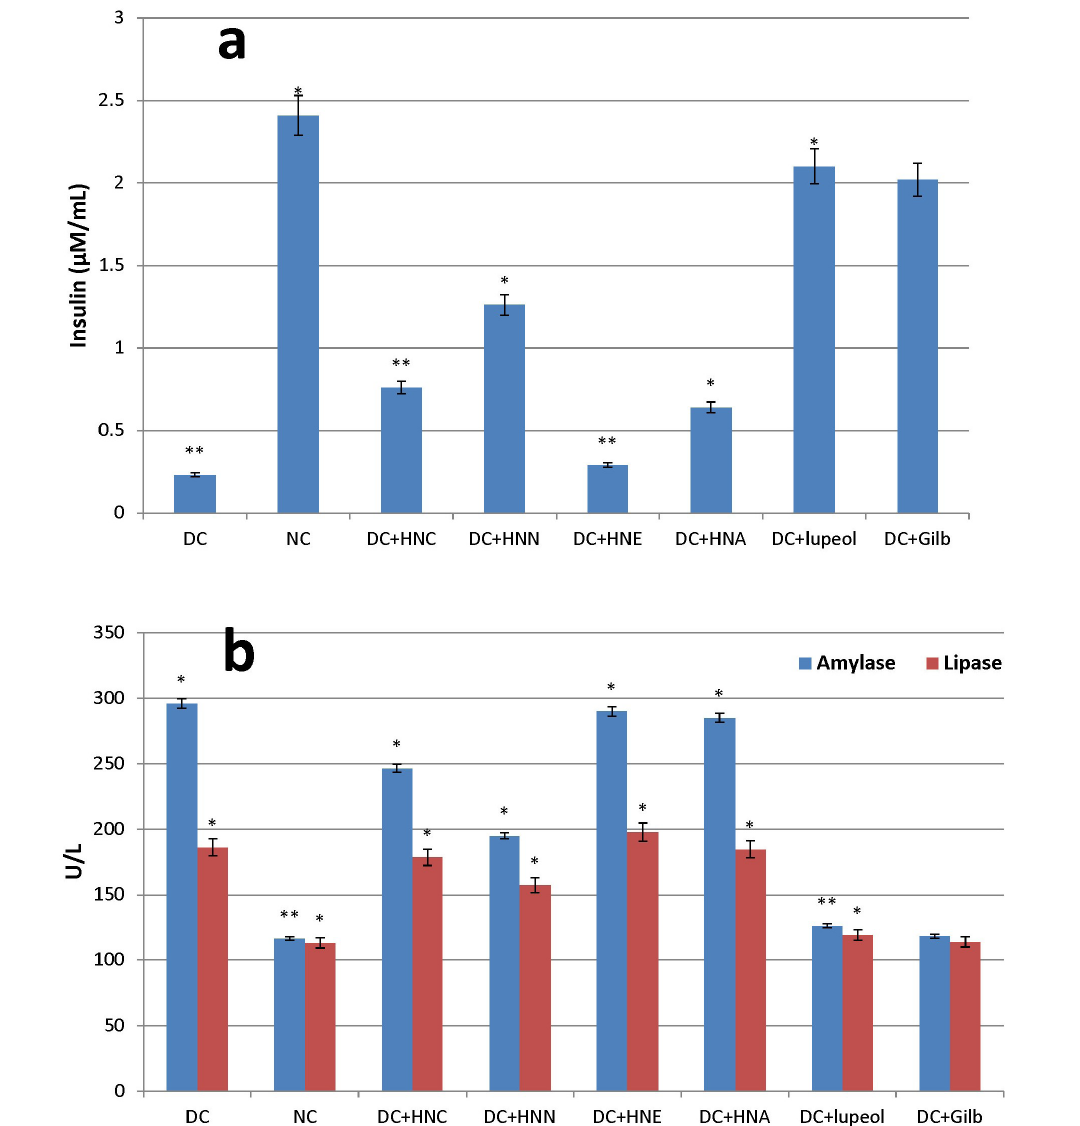
FIGURE 2 - (a) insulin level (b) amylase and lipase level after 15 days of treatment. Values are *p<0.05 and **p<0.01